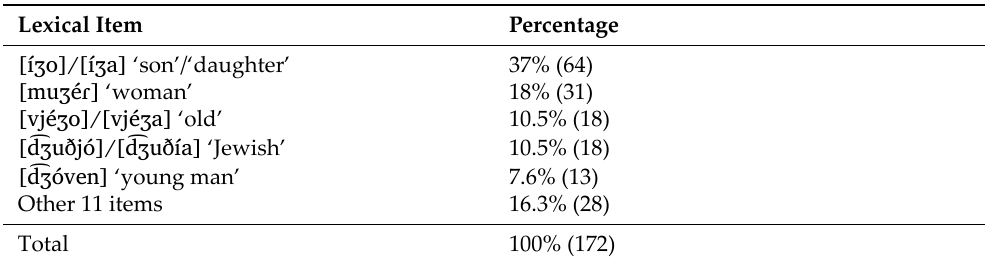
Table 1. Native words most frequently accommodated with / x / in the JS of Istanbul and the Prince Islands (adapted from Romero 2013, p.